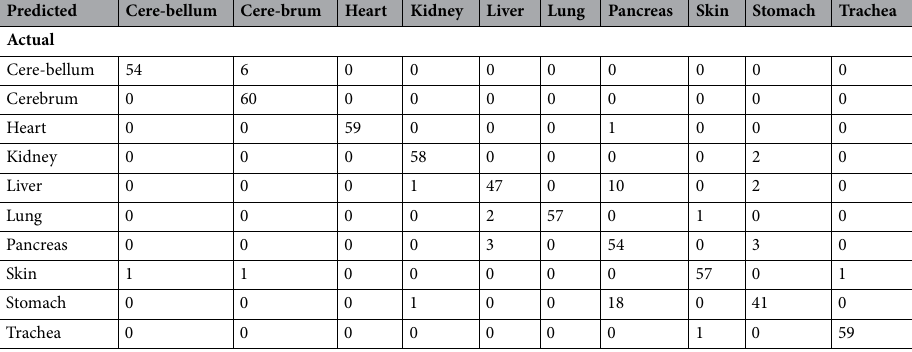
Table 11. Aggregated confusion matrix of 05 students who attained accuracy close to the VML model.